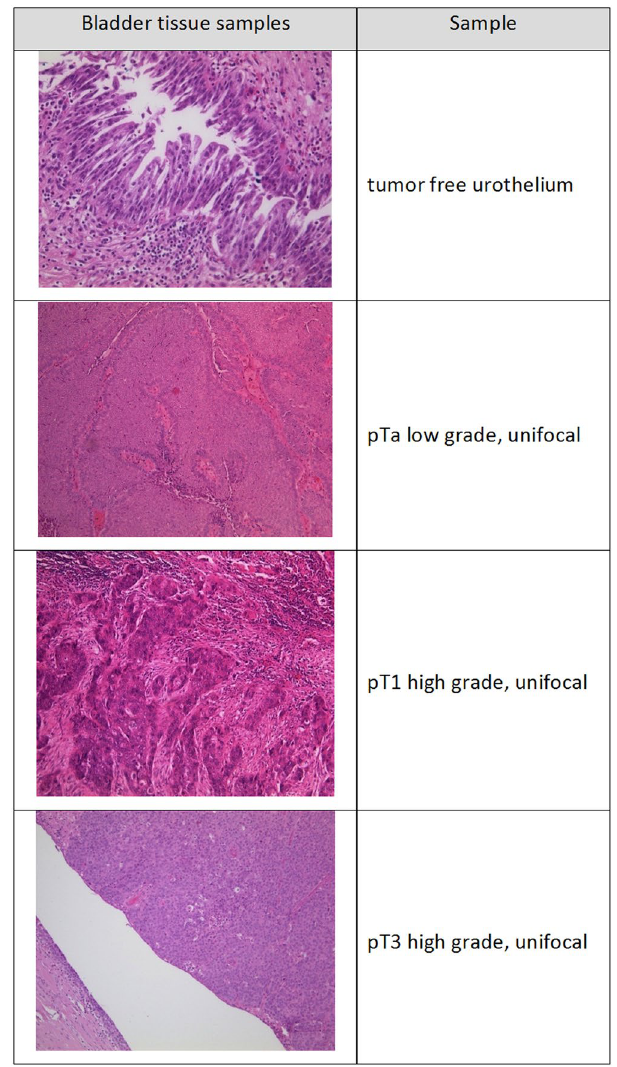
Figure 7. Representative pictures of pathologically classified tissue samples used for methylation